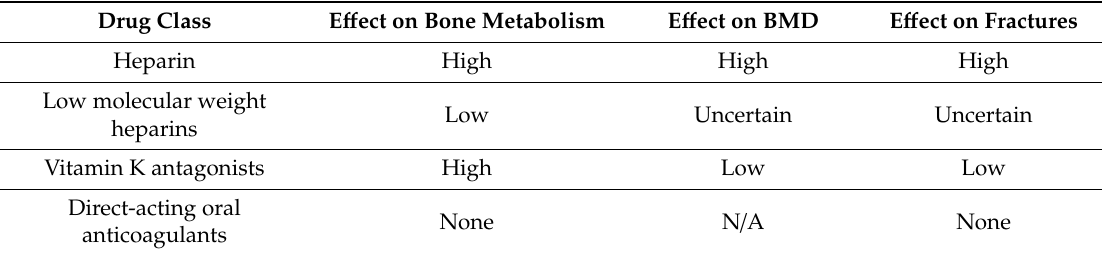
Figure 1. Anticoagulants’ safety on bone. LMWHs (Low molecular weight heparins), VKAs (Vitamin K antagonists), DOACs (Direct-acting oral anticoagulants). Table 2. Summary of the effects of anticoagulants on bone metabolism, bone mineral density (BMD), and fractures.